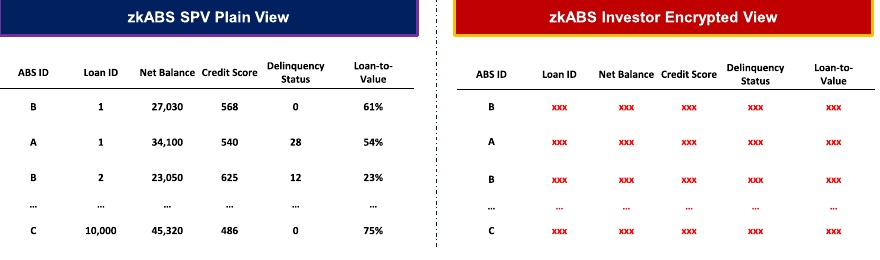
Fig. 5 zkABS plain and hidden